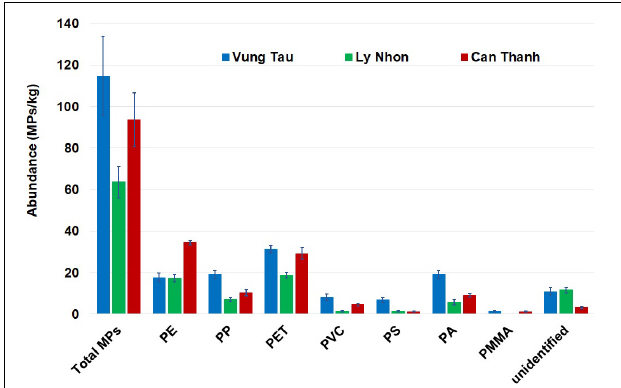
FIGURE 3 | Compositions of microplastics collected from the sea